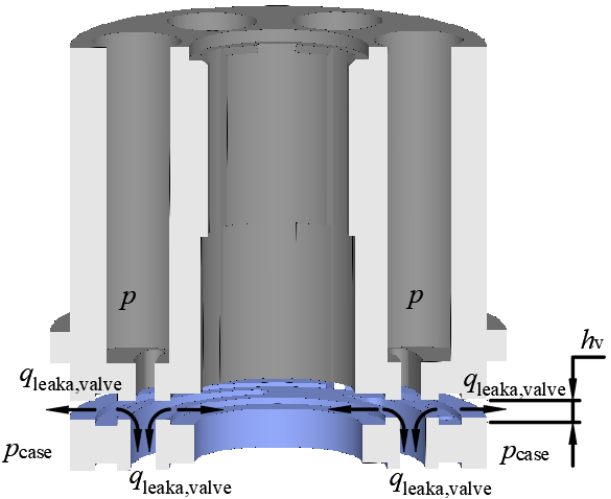
Figure 6. Schematic diagram of leakage flow of the cylinder block/valve plate interface.